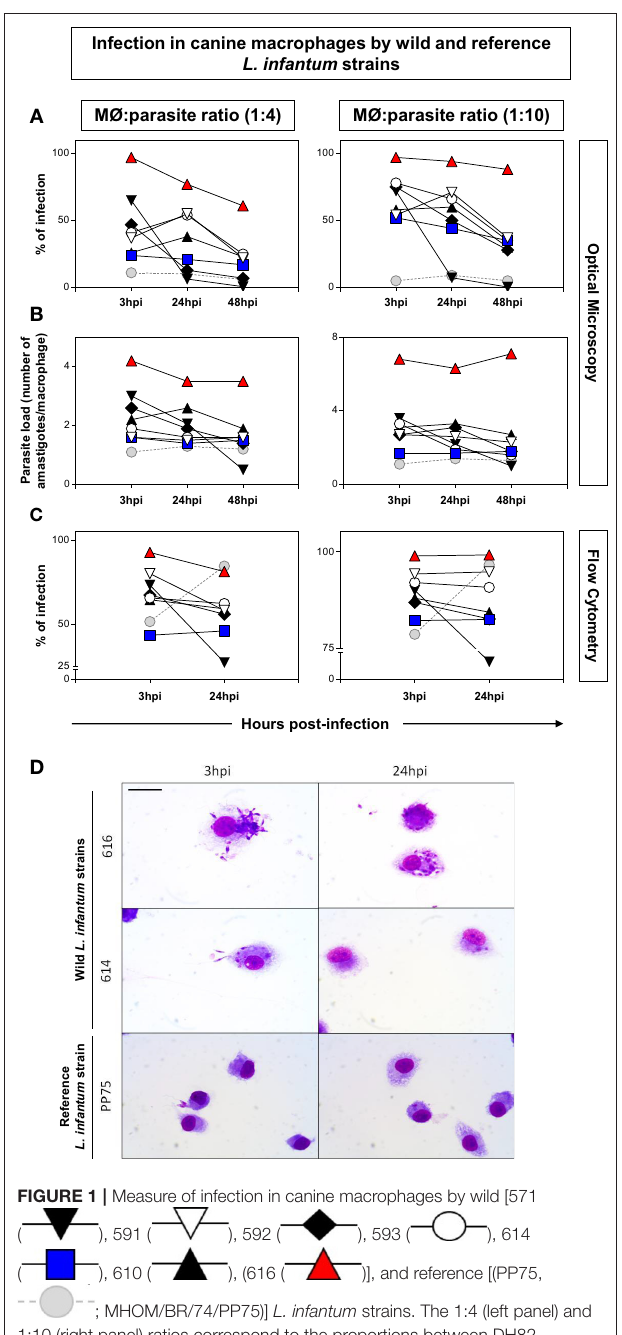
)], and reference [(PP75, ; MHOM/BR/74/PP75)] L. infantum strains. The 1:4 (left panel) and 1:10 (right panel) ratios correspond to the proportions between DH82 macrophages (MØ) and parasites. Distinct proportions of macrophage: promastigotes were displayed in the left (1:4) and right panels (1:10). The y-axis shows the percentage of infection (A,C) and parasite load (B) . The x-axis shows the time periods (3, 24, and 48 h) post-infection. The data were obtained by optical microscopy (A,B) or flow cytometry using parasites labeled with CFSE (C) . The data were displayed as descriptive analyses given they are representative of each strain. (D) : Immortalized canine DH82 macrophages infected with wild (614 and 616) and reference (PP75) L. infantum strains. The macrophages were observed 3 and 24 h post-infection. Bar = 20 µ